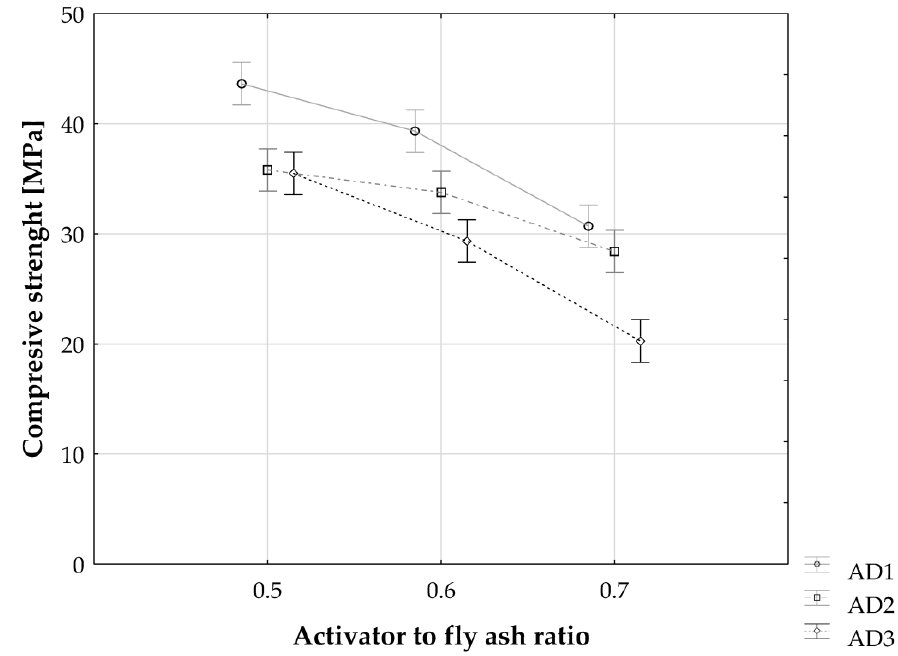
Figure 4. Compressive strength results depending on the activator to fly ash ratio (ANOVA certainty in whiskers).